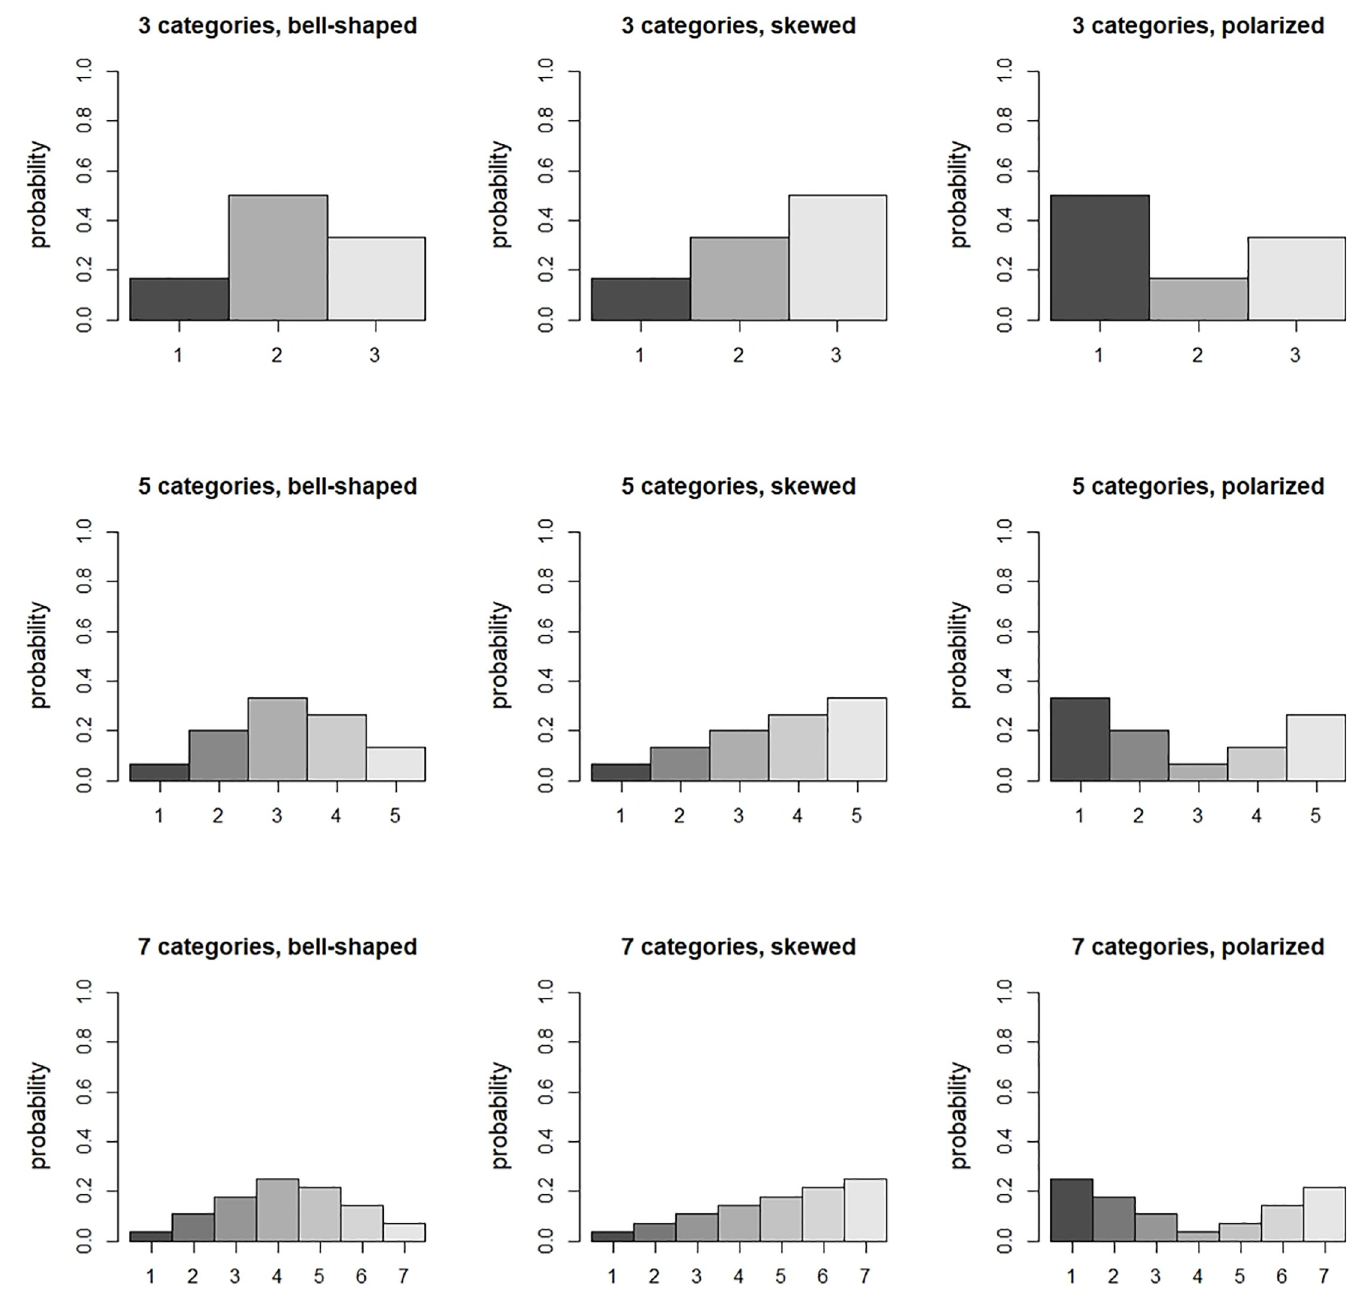
Fig 1. Response probabilities in the control